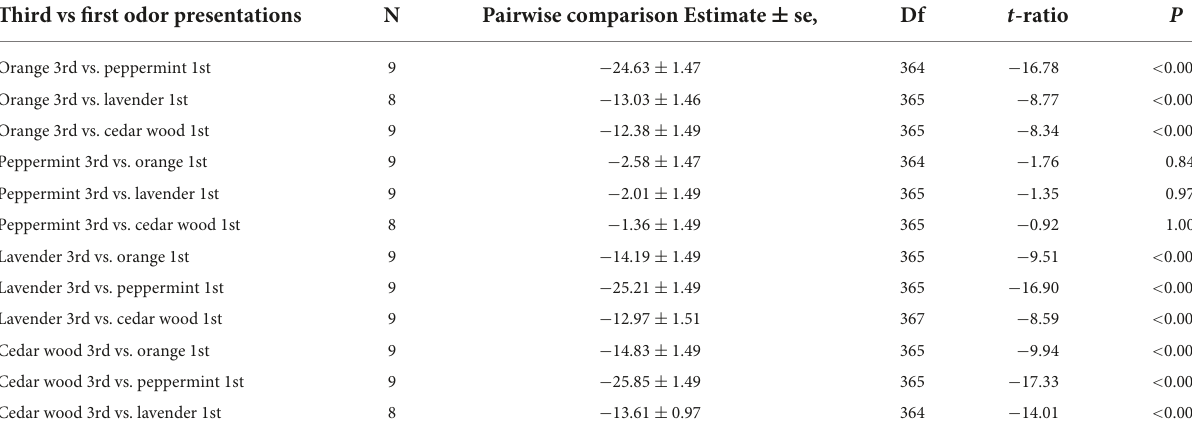
TABLE 3 Results from final model, the pair wise comparisons of each pair of 3rd and 1st odor presentations, with sample size, estimate ± se, df, t -ratio and P